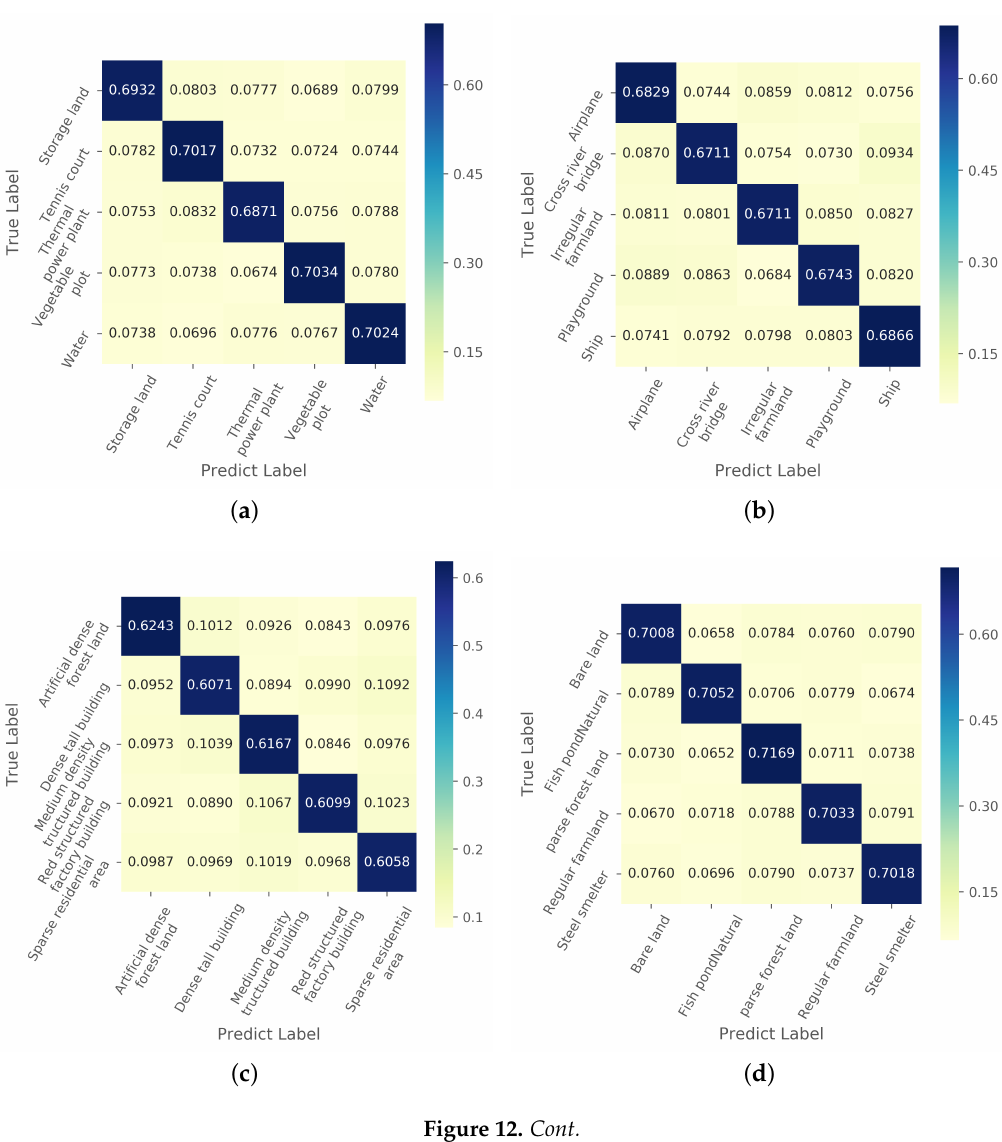
Figure 11. Experimental results on the RSD46-WHU dataset, each experiment contains 600 randomly selected tasks.